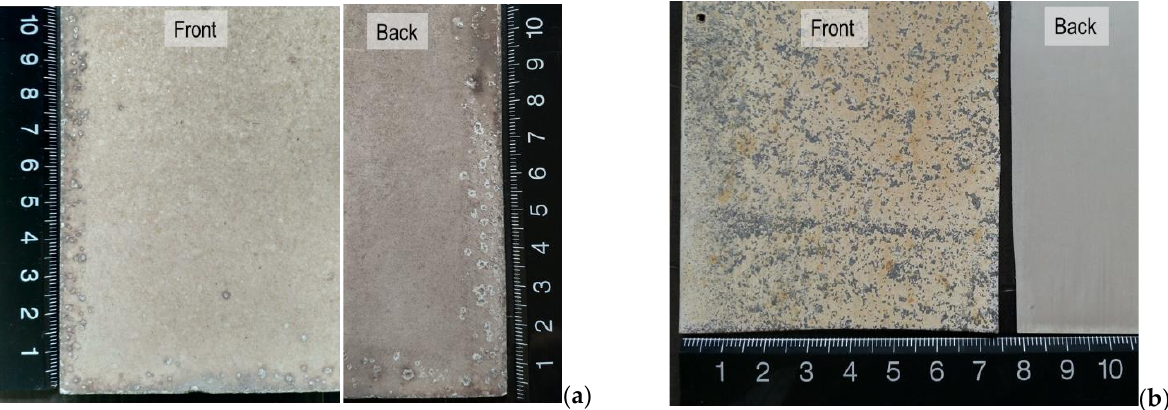
Figure 3. Details of the visual aspects of the front (exposed) and back surfaces after ten years of exposure at the test sites: ( a ) Barreiro (industrial – marine); ( b ) Rodão (industrial).